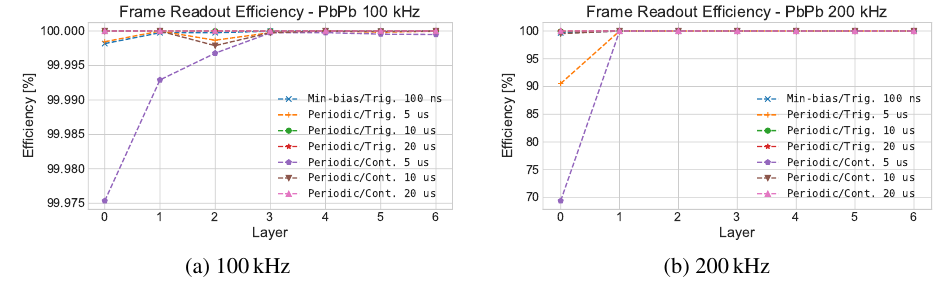
Figure 7: Frame readout e ffi ciency in Pb–Pb